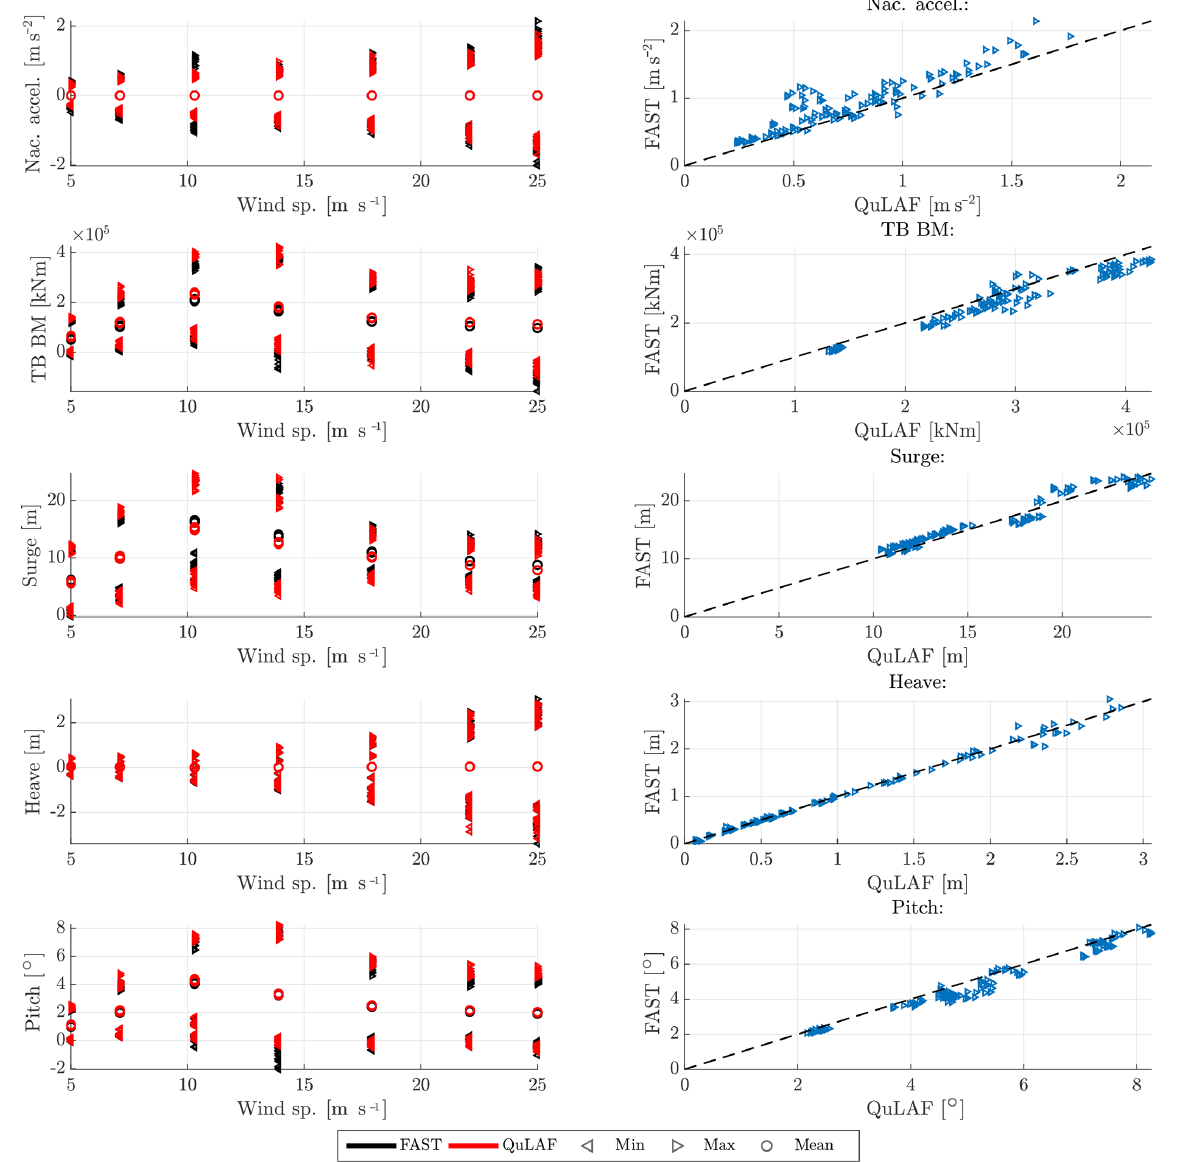
Figure 3. Response to DLC 1.2 for FAST and QuLAF. Left: min., max. and mean values for every realization as a function of wind speed. Right: maximum values for FAST as a function of the corresponding maximum values in QuLAF. Table 5. Ratio of max. response (QuLAF / FAST) averaged per wind speed for DLC